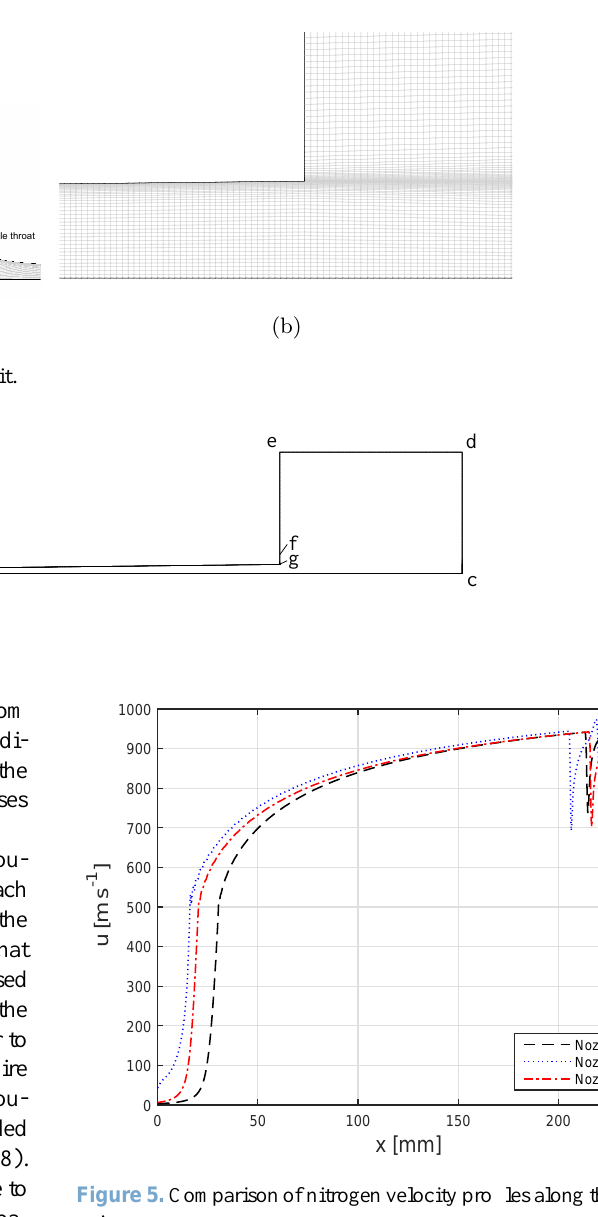
Figure 5. Comparison of nitrogen velocity profiles along the nozzle